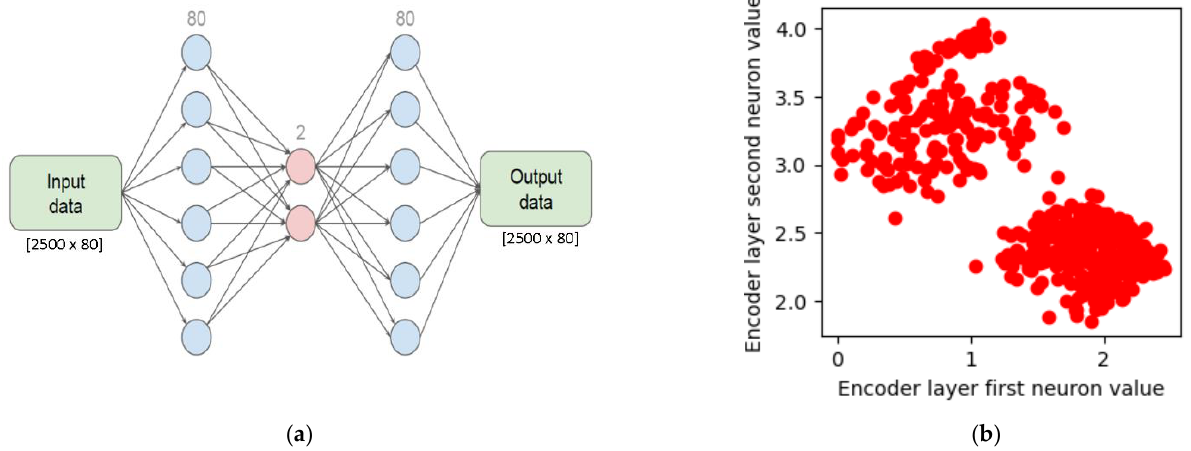
Figure 10. ( a ) Visual representation of the autoencoder’s architecture; ( b ) Visualization of encoding neurons for the training dataset.